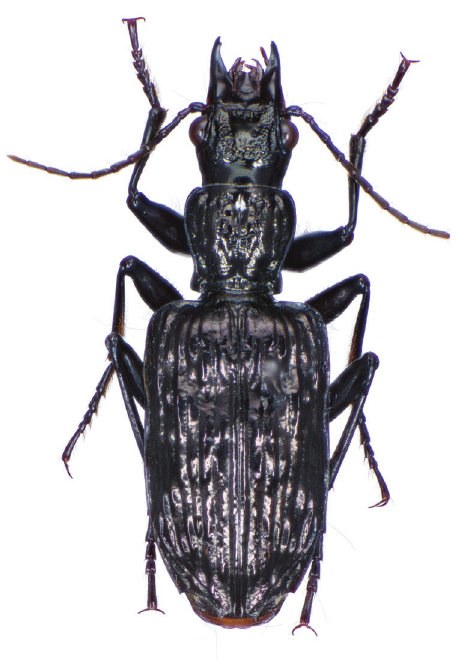
Figure 30. Dorsal habitus and color pattern of C. ( Catascopoides ) horni Jedlička (OBL 17.20 mm). from C. (C.) horni. After dissecting the available material including the specimens that were examined and thought to be C. (C.) mirabilis by both Jedlička (1963) and Habu (1967), it seems apparent that C. (C.) horni is restricted to Taiwan while C. (C.) mi- rabilis is known from Vietnam, Laos and China. See also “Geographical distribution”.